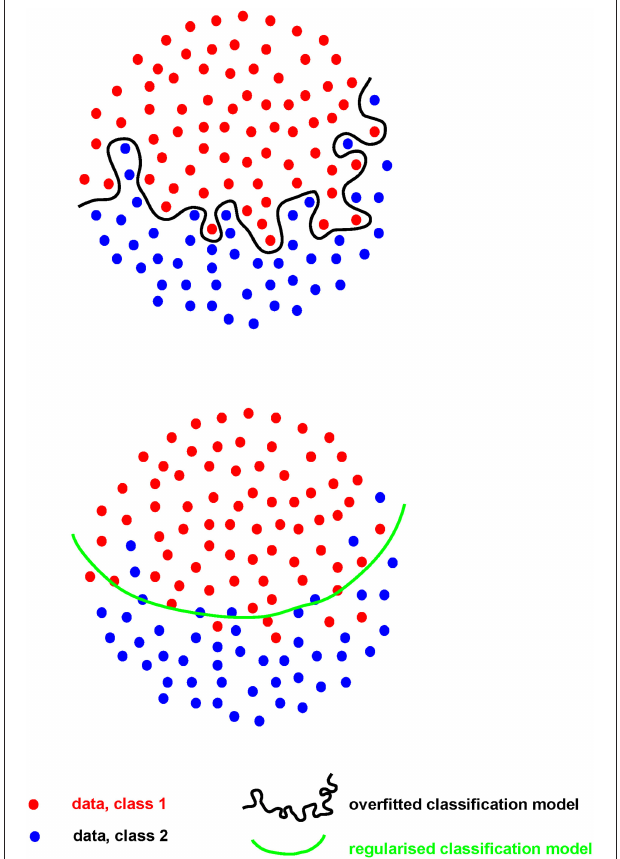
FIGURE 2 | The concept of overfitting and model